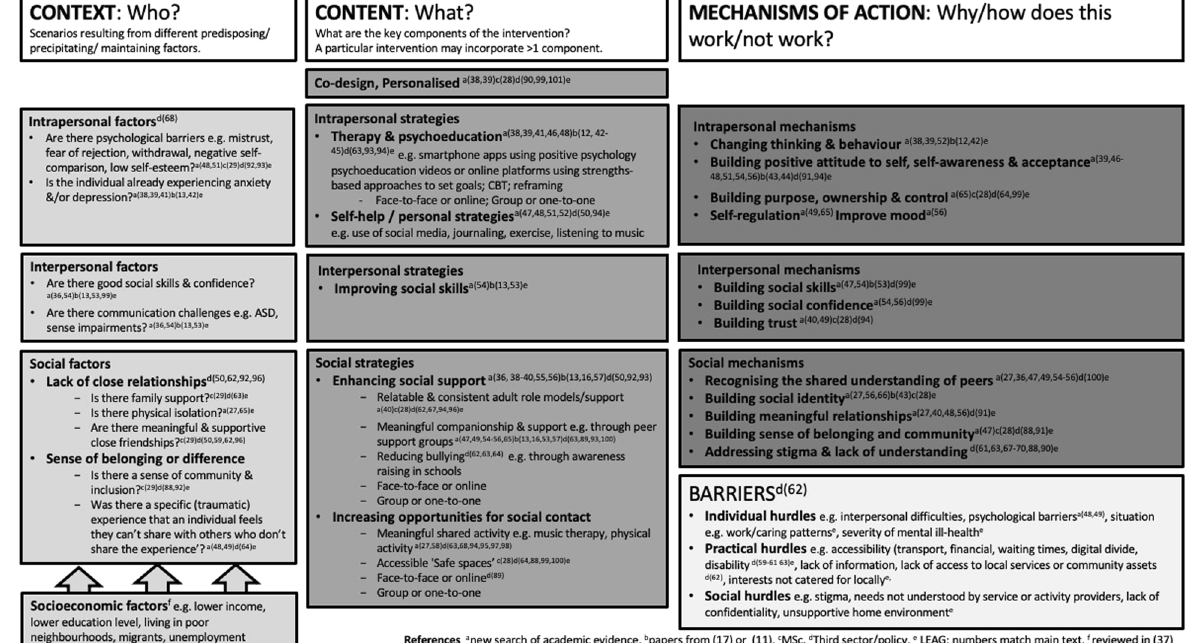
Fig. 2 Conceptual framework of interventions to address loneliness in young people. Synthetic constructs are given in bold and are structured under the overarching themes of Context (who an intervention might work for), Content (what the intervention involves), Mechanisms (how and why an intervention might work) and Barriers (why an intervention might not work). Sub-constructs are bullet-pointed and given in bold, and their attributes are also provided. References: anew search of academic evidence, b papers from [17] or [11], c MSc, d Third sector/policy, e LEAG; reference numbers match the main text, f reviewed in